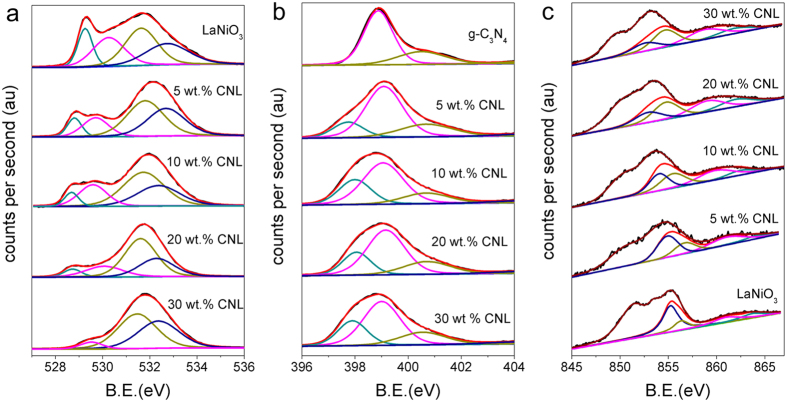
(a) O 1s XPS spectra, (b) N 1s XPS spectra and (c) Ni 2p3/2 XPS spectra of LaNiO3 and x wt.% CNL (x = 5, 10, 20 and 30) composite catalysts.